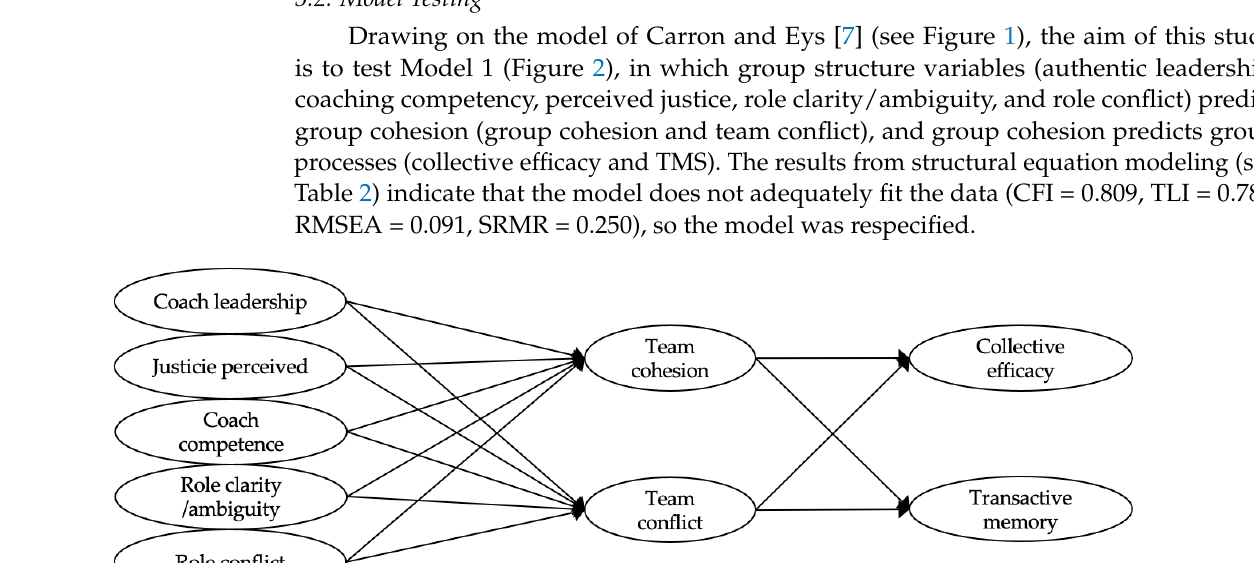
Table 1. Descriptive statistics, normality, and internal consistency.